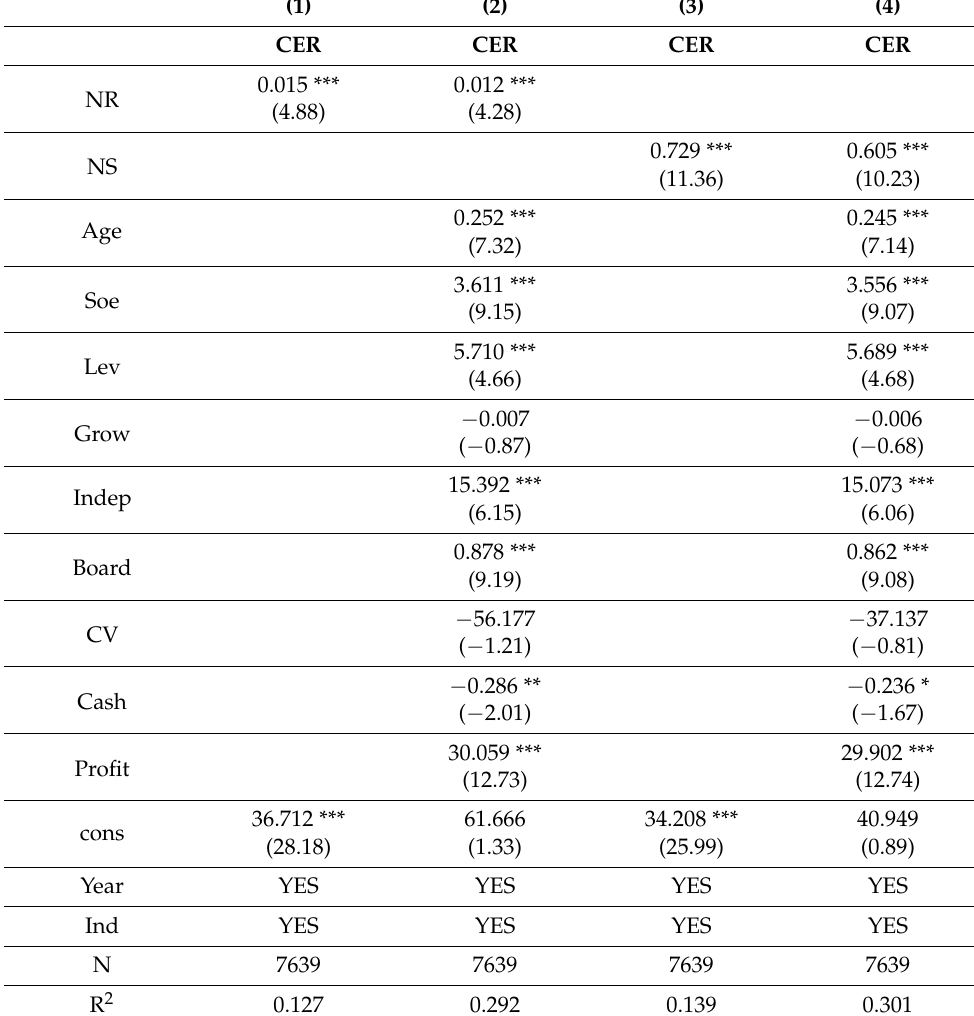
Table 4. The results of the primary effect